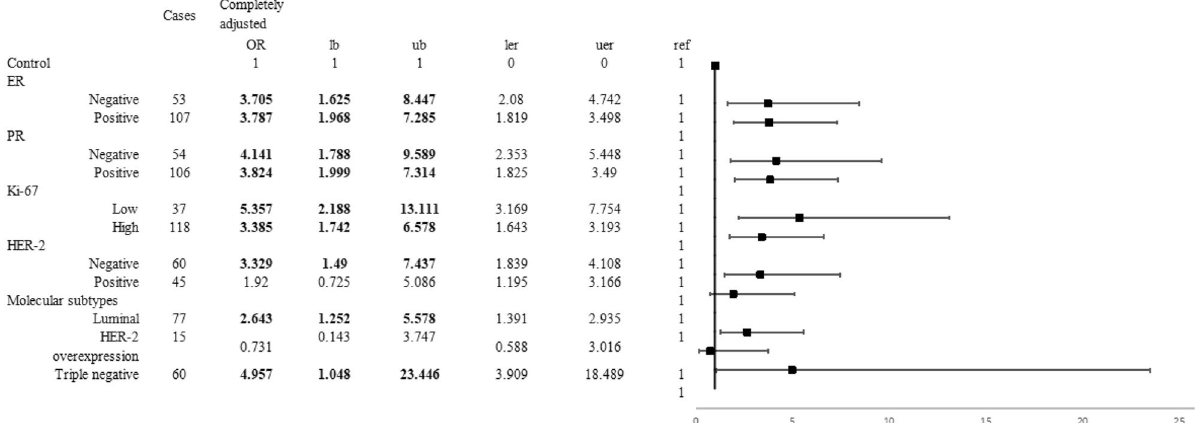
Figure 5. The association between PS 5pre and the risk of premenopausal breast cancer risk of different molecular subtypes. *lb the lower limit of confidence interval, ub the upper limit of confidence interval, ler the distance from OR to the lower limit of confidence interval, uer the distance from OR to the upper limit of confidence interval, ref OR = 1. The figures were conducted using R 3.5.1 software (R Core Team, Vienna, Austria, 2018. https:// www.R- proje ct. org/) and Microsoft EXCEL software (Microsoft, USA, 2016. https:// www. micro soft. com/ zh- cn/ micro soft- 365/ excel).